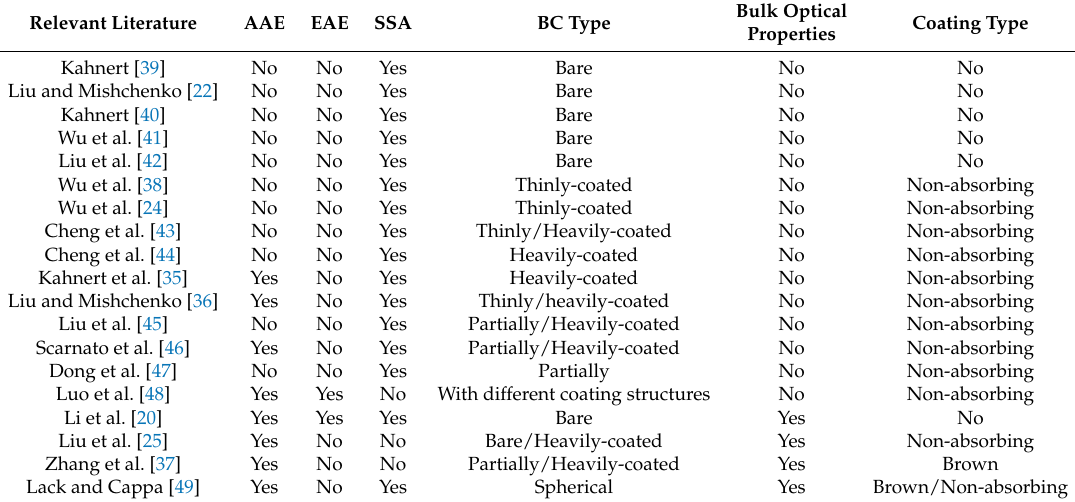
Table 1. Relevant literature on the numerical investigation of absorption Ångström exponent (AAE), extinction Ångström exponent (EAE), and single-scattering albedo (SSA) of black carbon (BC). Relevant Literature AAE EAE SSA